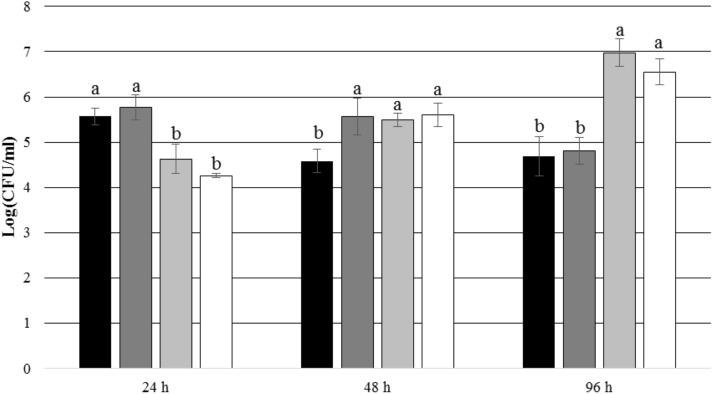
Number of attached P. inhibens wt and P. inhibens ΔtdaB with f/2 medium inside the chamber. Grouping based on ANOVA post hoc Tukey test. Groups within each sampling time that do not share a letter are significantly different (24 h: P = 0.000; 48 h: P = 0.006; 96 h: P = 0.000).
P. inhibens wt with f/2 medium, experimental membranes;
P. inhibens wt with f/2 medium, control membranes;
P. inhibens ΔtdaB with f/2 medium, experimental membranes;
P. inhibens ΔtdaB with f/2 medium, control membranes.